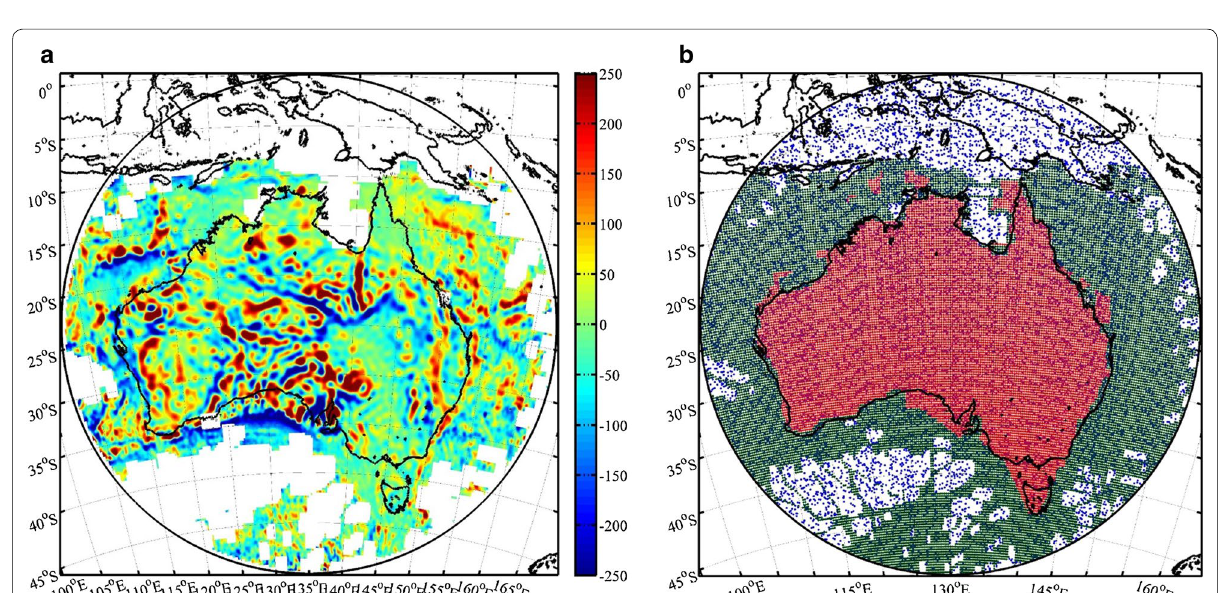
Fig. 2 a Australian magnetic anomaly grid from the combined low-pass-filtered fourth and fifth editions; b near-surface and satellite vector obser- vations used in this study include the low-pass-filtered Australian fifth edition magnetic grid values at a 0.25° interval ( red dots ), the low-pass-filtered fourth edition of magnetic grid values at a 0.25° interval ( green dots ), and the selected CHAMP satellite vector component observations ( blue dots ) from the final 2 years of mission. See Table 3 for the statistics of the magnetic anomaly maps produced in this and the other figures of this